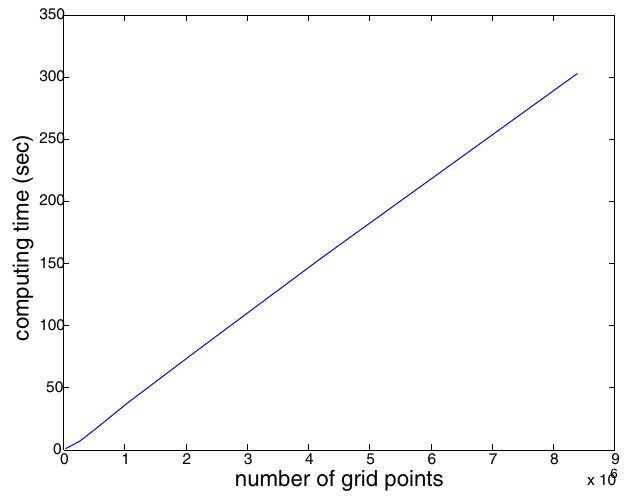
FIG. 8. (Color) Computing time of solving the 3D Poisson equation as a function of number of grid points using the FFT based integrated Green function method.